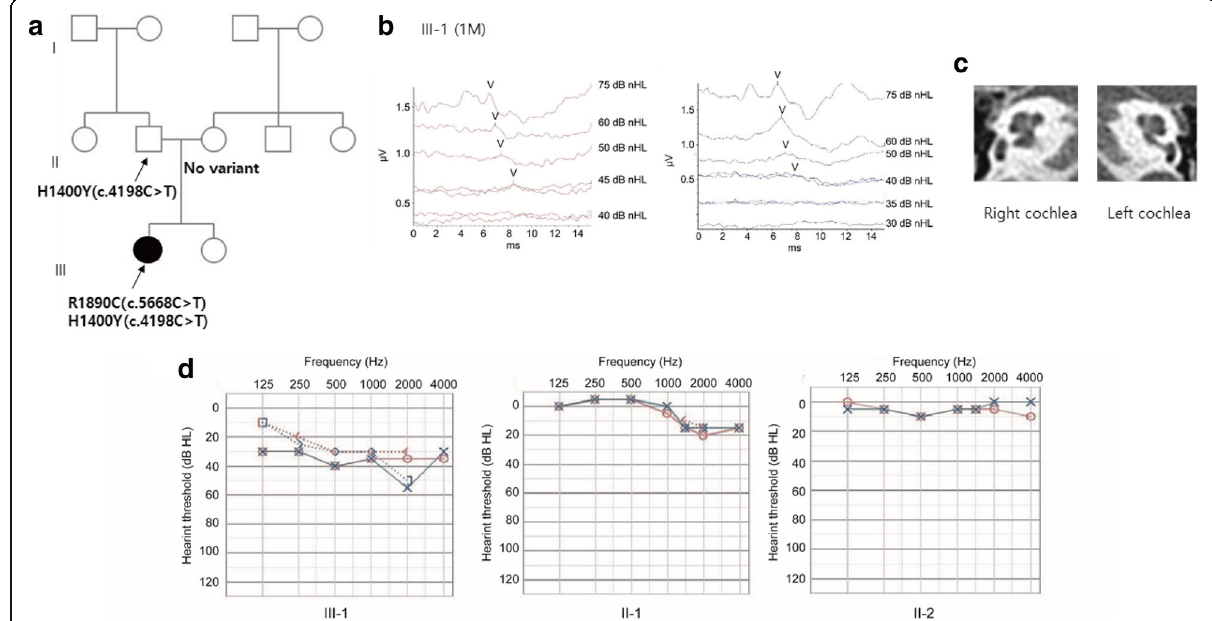
Fig. 1 a Pedigree of the family with a de novo mutation causing hearing loss in the proband (filled circle). b Auditory brainstem response (ABR) of the proband (III-1) at 1 month after birth. c Temporal bone computed tomogram of the inner ear (III-1) d Pure-tone audiogram of the father (II-1), mother (II-2), and proband (III-1). Red and blue indicate thresholds for the right and left ears, respectively. Solid and dashed lines refer to air- and bone-conduction,